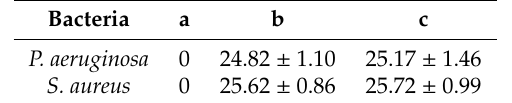
Table 2. Antimicrobial activity obtained for controls and sca ff